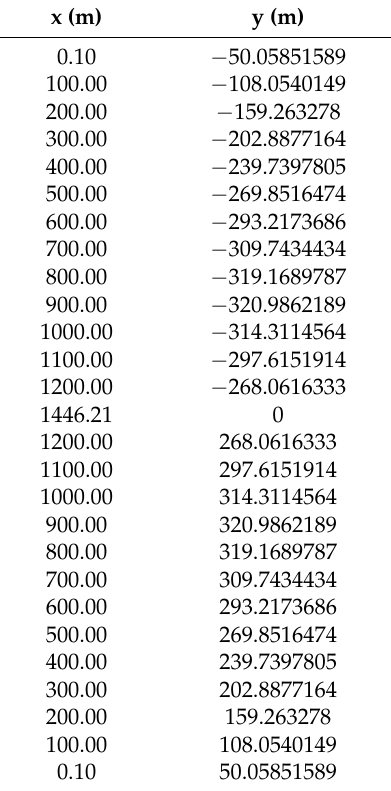
Table 5. The borders of the contaminated plume along axes x and y in the case of toxic risk for adults. x (m)